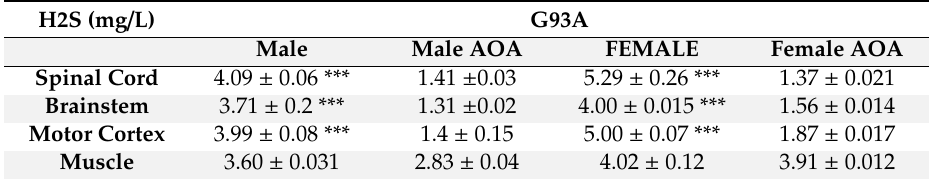
Table 3. AOA in vivo treatment decreases H 2 S concentration in cerebral tissues.